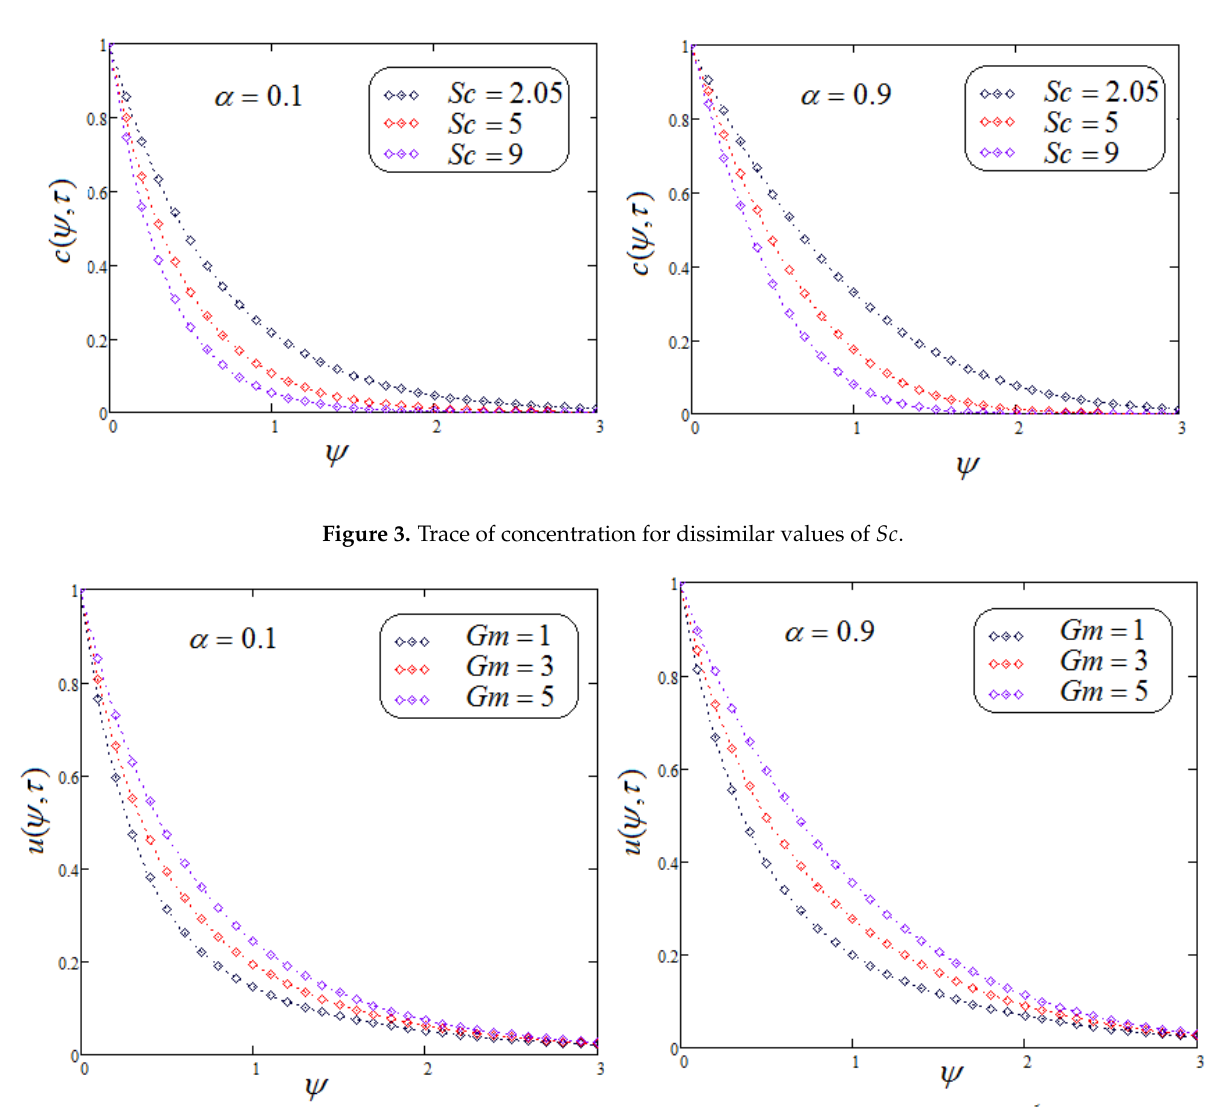
Figure 4. Trace of velocity for dissimilar values of Gm .